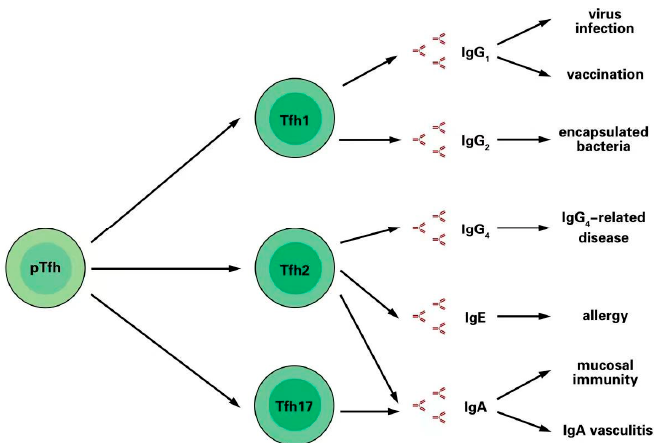
Figure 1. Tfh cell subsets support the production of immunoglobulins with different functions. Pre-Tfh (pTfh) cells can differentiate into Tfh1, Tfh2, or Tfh17 phenotypes under different microen- vironmental conditions due to different physiological or pathological states. Each Tfh cell subset is functionally specific and can mediate B cell differentiation to produce different types of immunoglob- ulins that participate in various immune